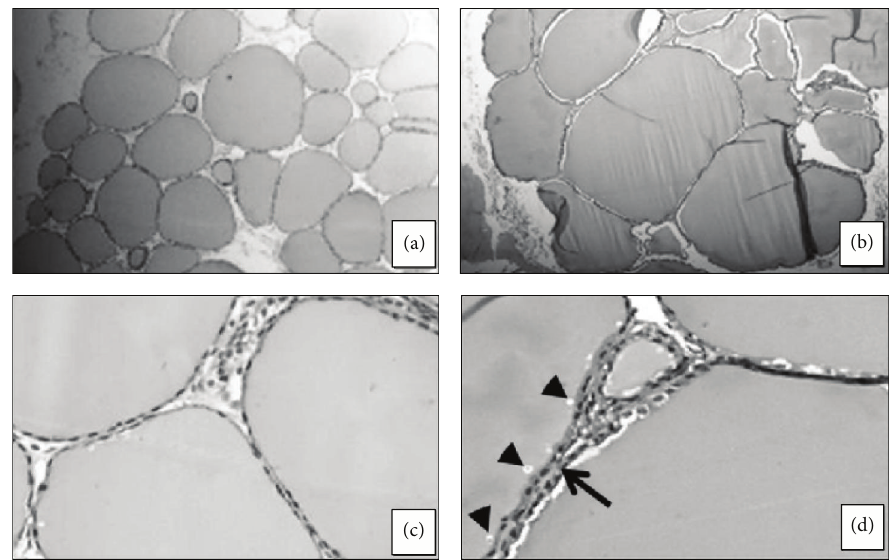
Figure 3: Light photomicrograph of pregnant sows thyroid: ((a) and (c)) animals from control group; ((b) and (d)) animals treated with 6.0 mg/kg of body weight of cyanide from day 21 of pregnancy to 110 term showing enlargement of thyroid follicles (b), thickening of the follicular epithelium (arrow; (d)), and reabsorption vacuoles in colloid (arrowhead; (d)). Magnification: × 4 ((a) and (b)); × 20 ((c) and (d)),